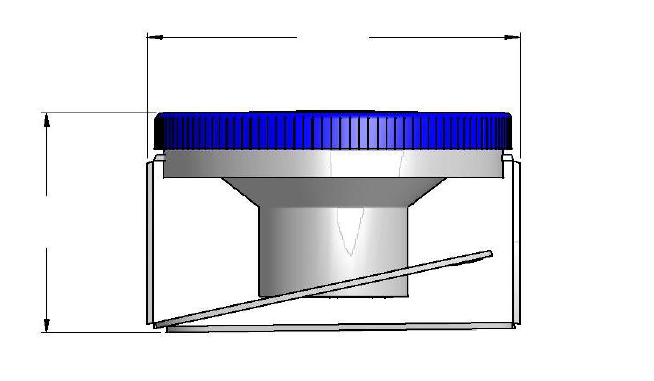
Figura 7. KITLAB quando sai da embalagem.